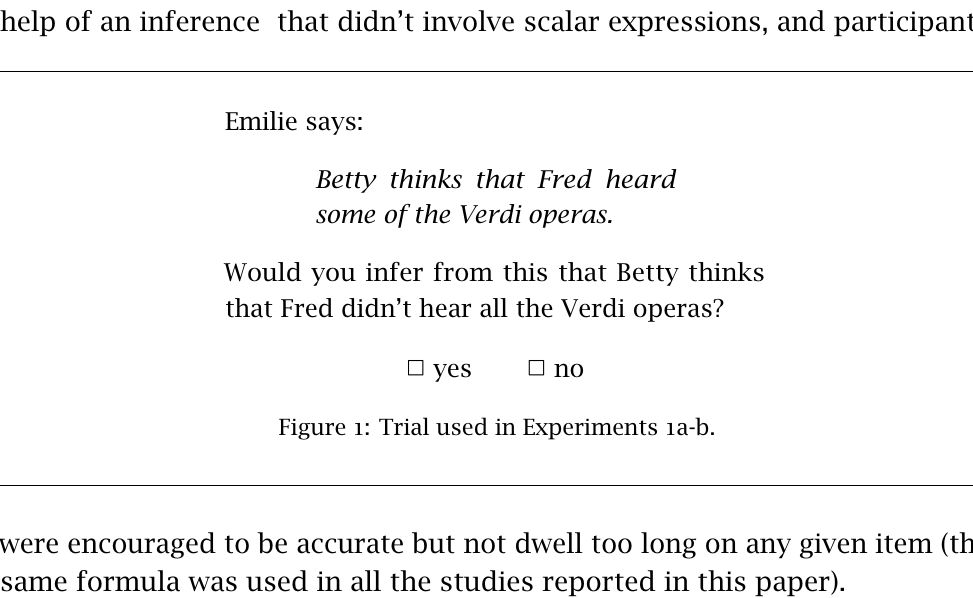
Figure 1 : Trial used in Experiments 1